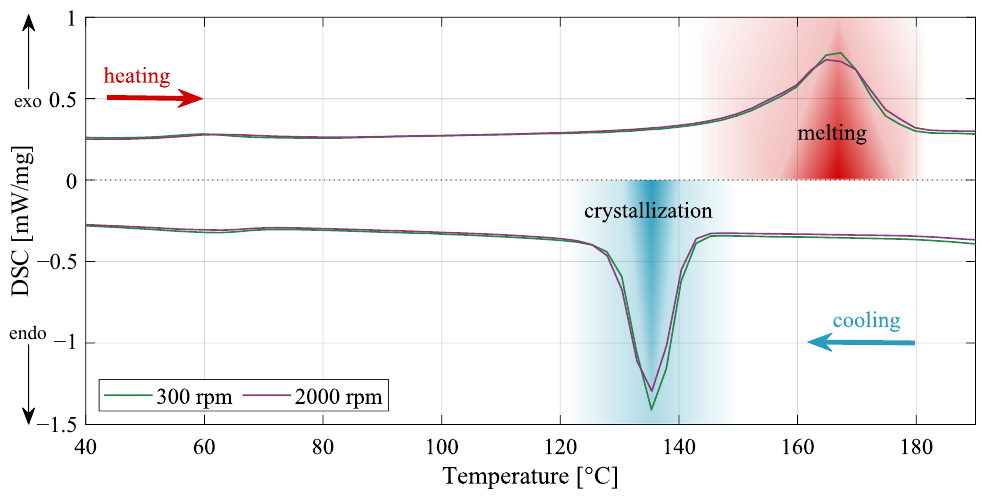
Figure 10. Differential scanning calorimetry (DSC) curves for both PVDF sample types. The differ- ences in exothermic and endothermic peak regions of DSC curves are